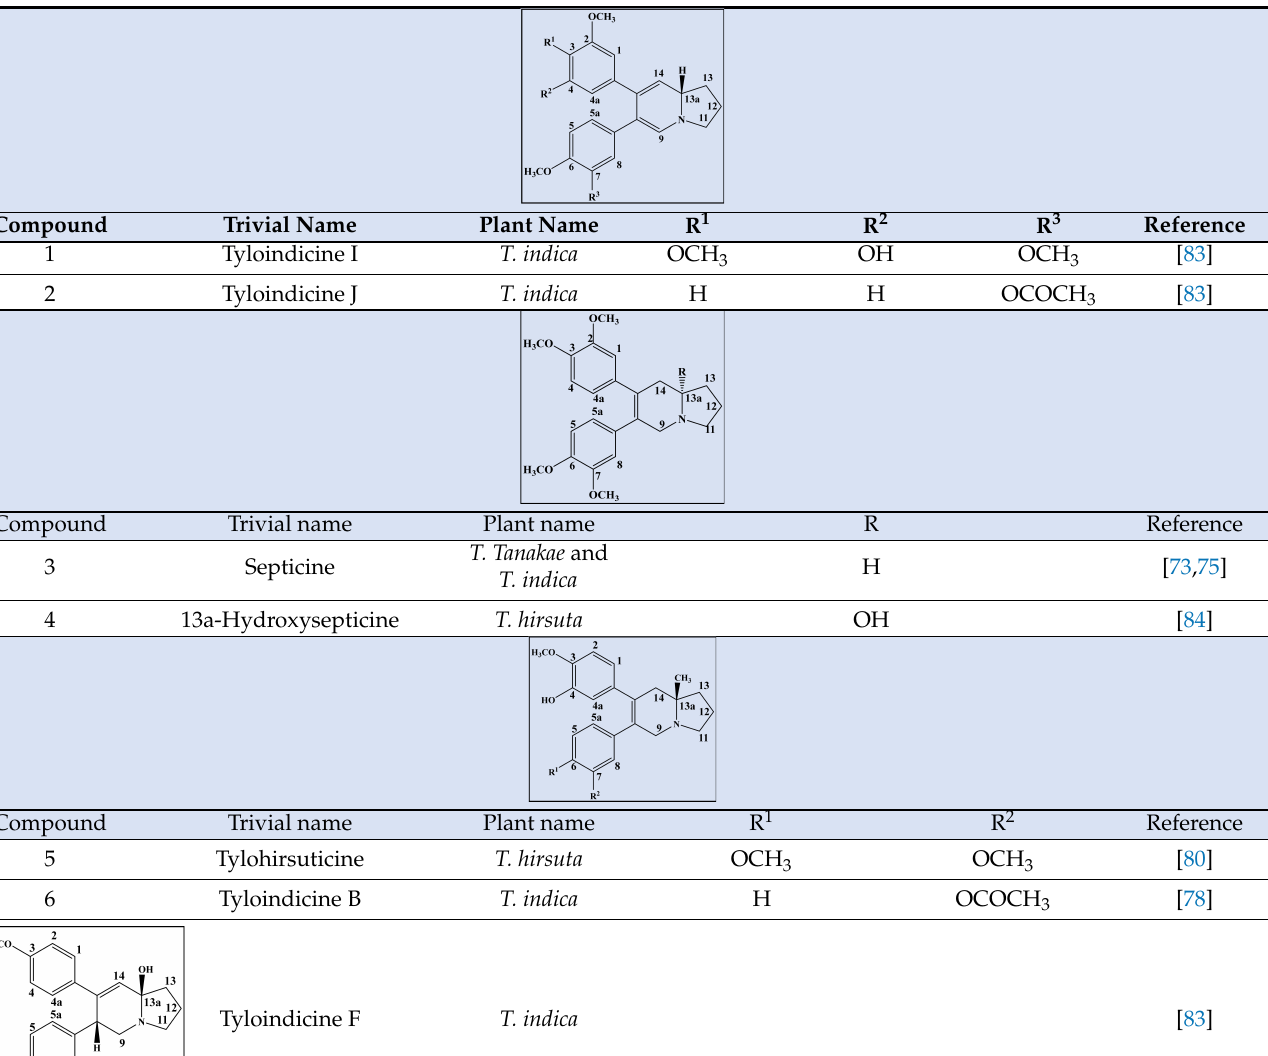
Table 4. Secophenanthroindolizidine alkaloids isolated from the genus Tylophora